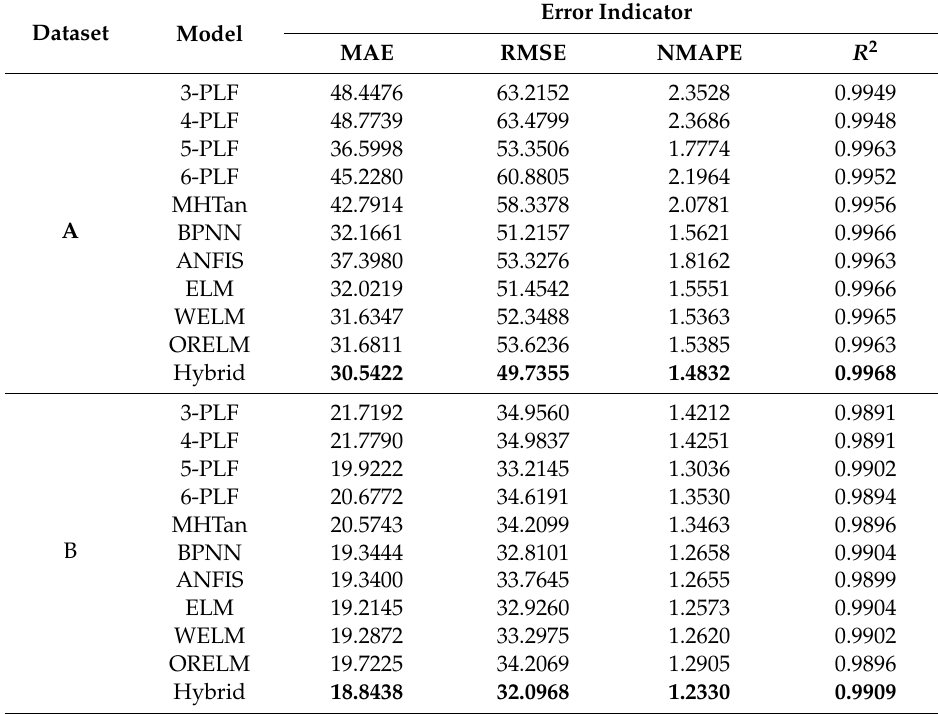
Table 8. Results of all power curve models on test sets of Dataset A and Dataset B. Dataset